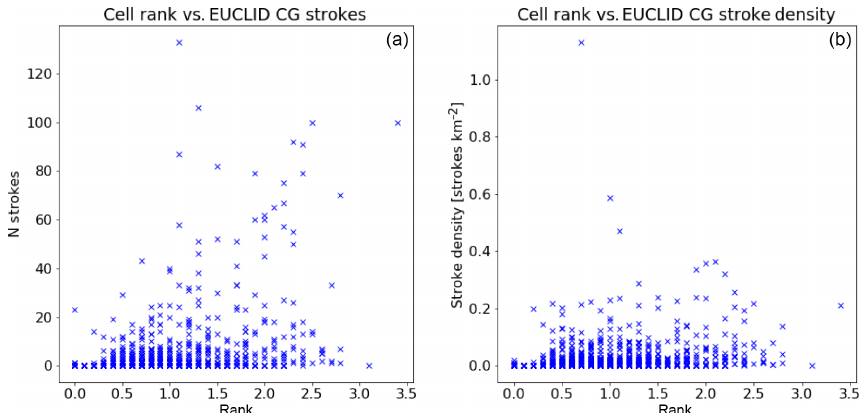
Figure 3. Scatter plot of rank versus (a) number of CG strokes within the TRT cell detected by the EUCLID network. (b) Density with respect to cell area. There are a total of 2792 points in each graph.